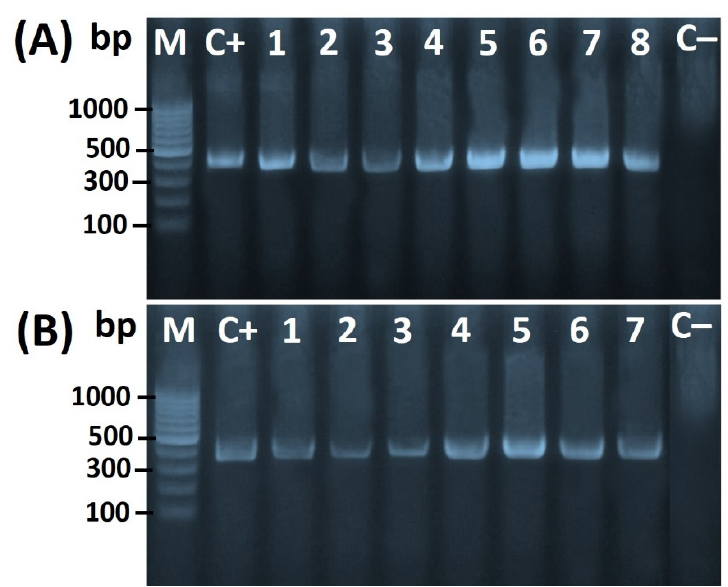
Figure 1. ( A ) H. pylori (lanes 1–8) . ( B ) H. pullorum (lanes 1–7) . Agarose gel electrophoresis